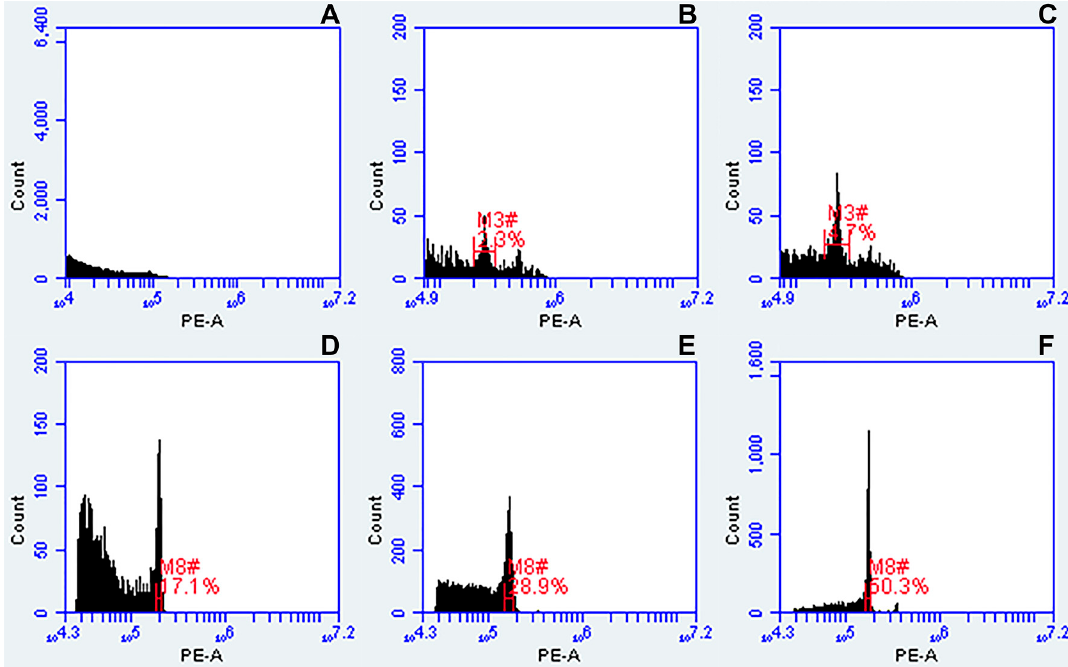
Figure 3. Comparison of three different standard buffers for nuclei isolation from dried leaves of tetraploid Urochloa accessions, and their effect on histogram quality. ( A ) Galbraith’s buffer; ( B ) Otto’s buffer; ( C ) Otto’s buffer supplemented with 15 mM β -mercaptoethanol and 1% PVP-40 (Modified Otto, see Table 2); ( D ) Partec buffer; ( E ) Partec buffer supplemented with β -mercaptoethanol; ( F ) Partec buffer supplemented with 15 mM β -mercaptoethanol and 1% PVP-40 (Modified Partec, see Table 2). Regions of identification (red marks) were placed across the peaks to export fluorescence values representing peak positions and CVs.